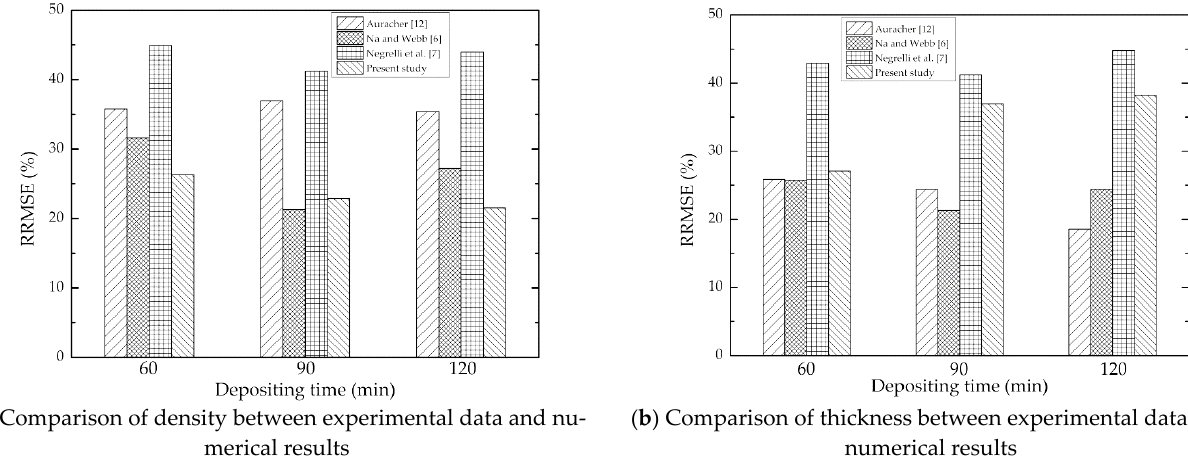
Figure 9. The error analysis of predicted density and thickness by means of different correlations.